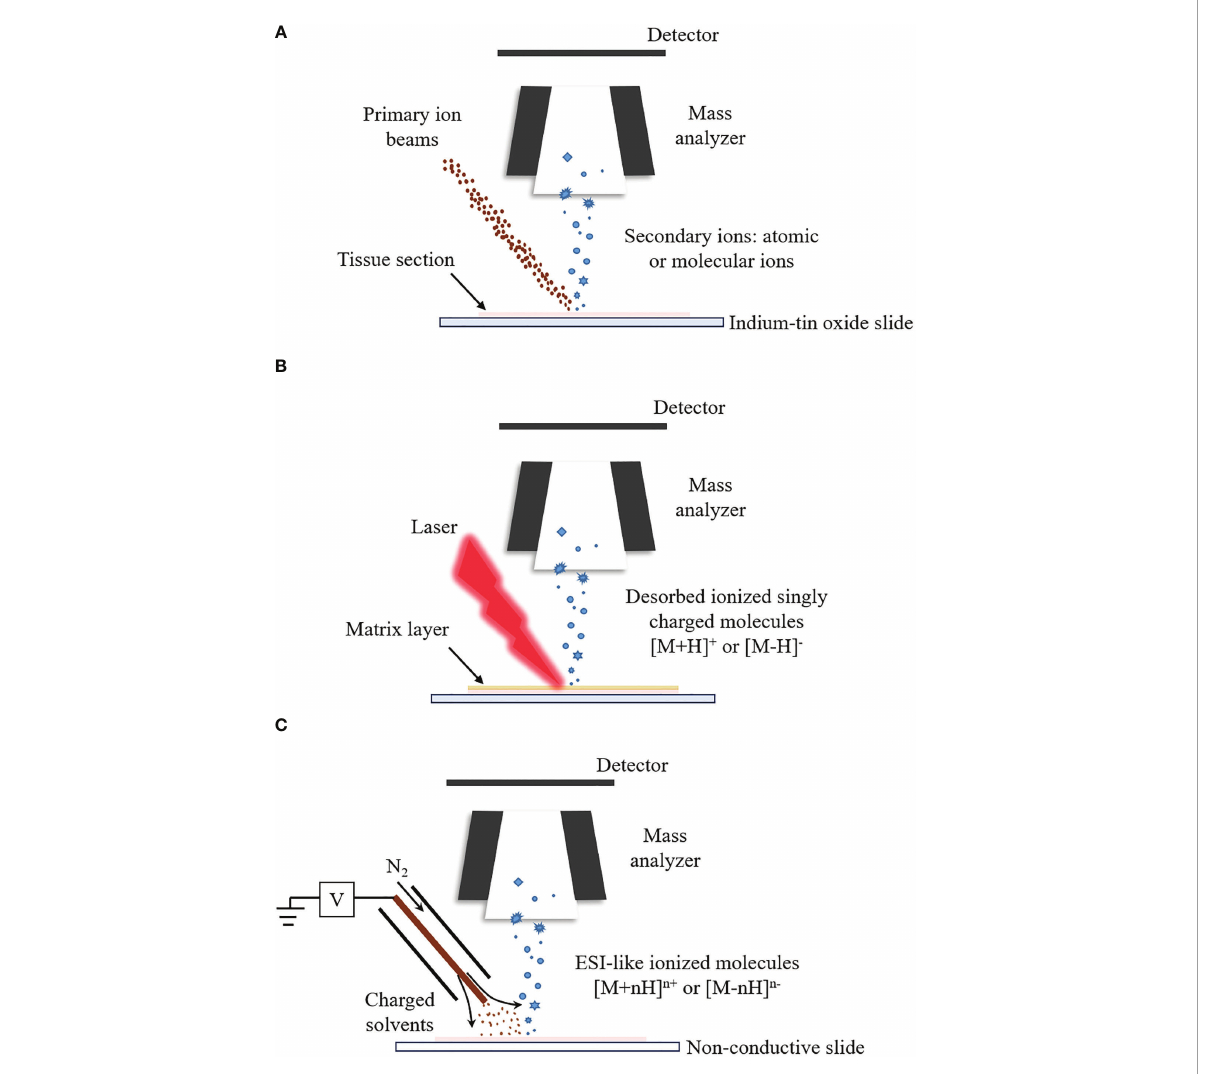
FIGURE 1 The ionization principles for SIMS-MSI, MALDI-MSI and DESI-MSI. A mass spectrometer is at least composed of ion source, mass analyzer and detector. Different ion sources determine different ionization process. (A) Ionization process of SIMS-MSI. A primary ion beam possessing energy strikes the sample surface, causing the interaction between the ions and the surface. The interaction processes bring about the emission of atoms and molecules from the sample surface. (B) Ionization process of MALDI-MSI. Before the analysis, the matrix is applied to the sample surface. The matrix forms co-crystals with the analytes. The co-crystals can absorb the laser ’ s energy upon laser irradiation. The energy uptake then causes evaporation and desorption/ionization of the analytes. (C) Ionization process of DESI-MSI. It is carried out by applying pneumatically-assisted electrospray, which produces charged solvent droplets directly at the sample surface. The charged droplets impact the surface and produce gaseous